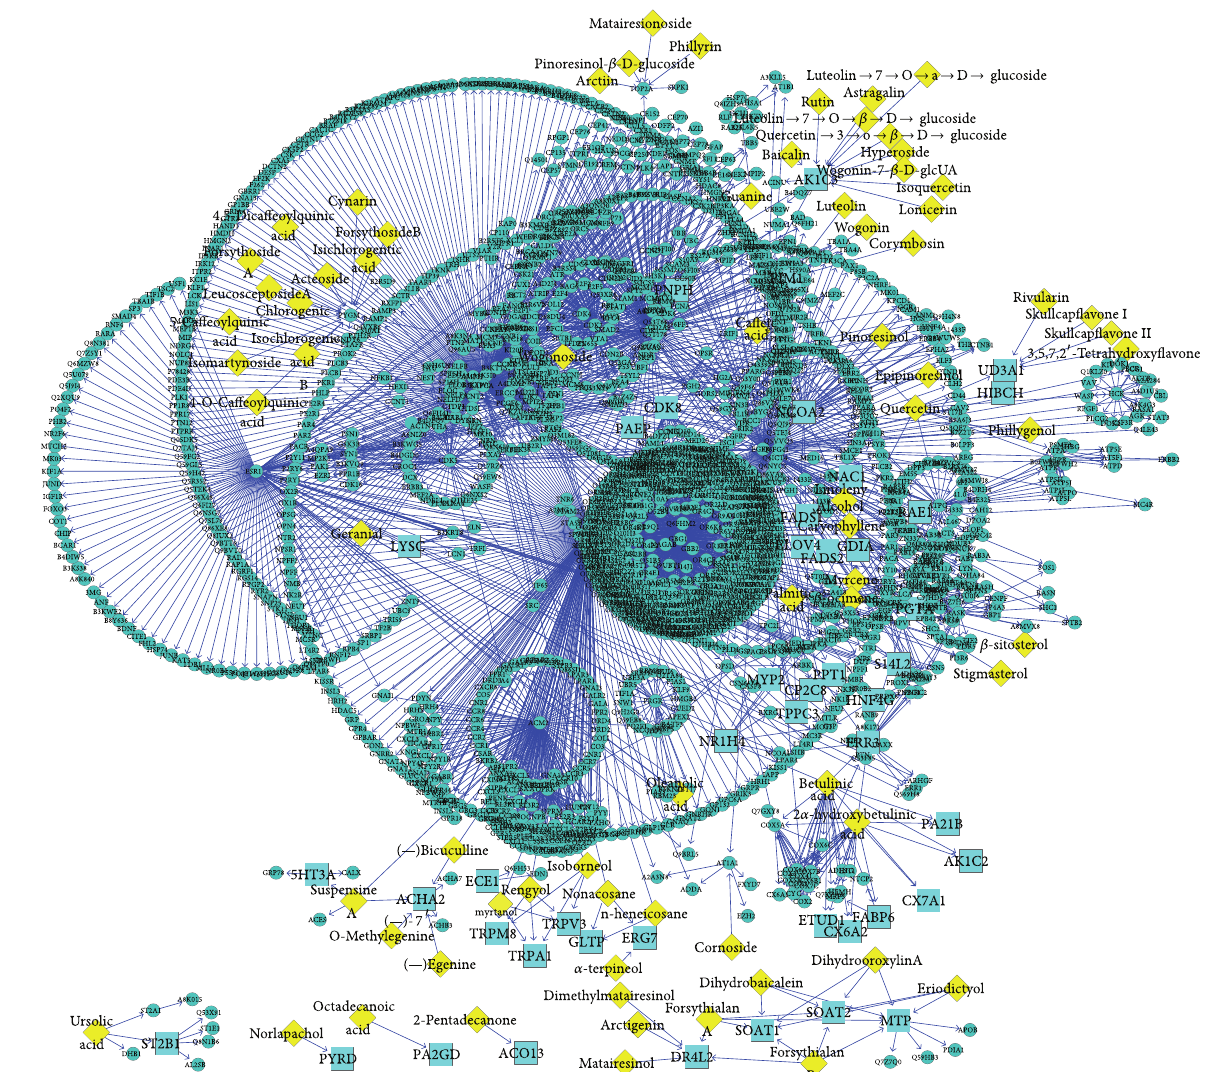
Figure 2: PPI Network of SHL. The components in SHL Network are yellow diamonds. The targets are shown as blue squares. In the PPI network, there are 92 components (Supplementary Table 3 ) acting on 129 targets which interact with 1787